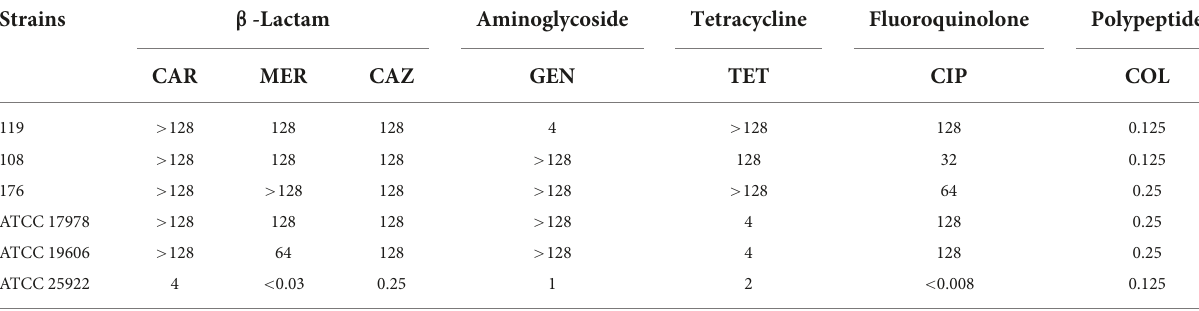
TABLE 1 Minimal inhibit concentration (MIC) values ( µ g/mL) of A. baumannii